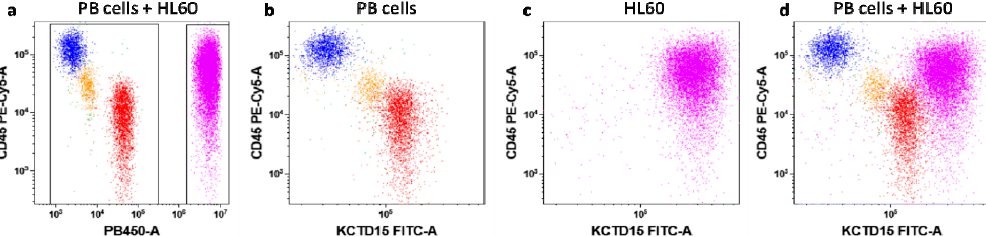
Figure 3. KCTD15 expression in peripheral blood (PB) and HL60 cells. Before the flow cytometry (FCM) acquisition of dot-plots ( a )–( d ), HL60 cells were stained with Violet Cell Tracer. Dot-plot ( a ) shows HL60 (violet events; right gate) distinguished from peripheral blood cellular populations (PB-cells; blue lymphocytes, orange monocytes, red granulocytes; left gate) due to Violet Cell Tracer fluorescence detected in PB450 channel. Dot-plots ( b ) and ( c ) display the surface CD45 vs. intracellular KCTD15 expression in PB-cells and HL60, respectively. Dot-plot ( d ) shows the brighter KCTD15 expression in HL60 cells in comparison to PB cell subsets.